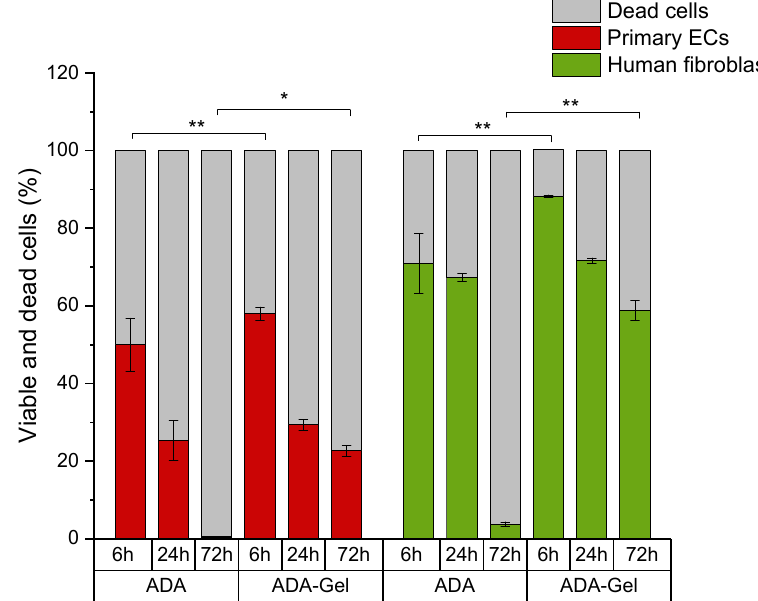
Figure 10. Comparison of cell viability between primary ECs and fibroblasts grown in ADA versus ADA-GEL. * p < 0.05, ** p < 0.001 .